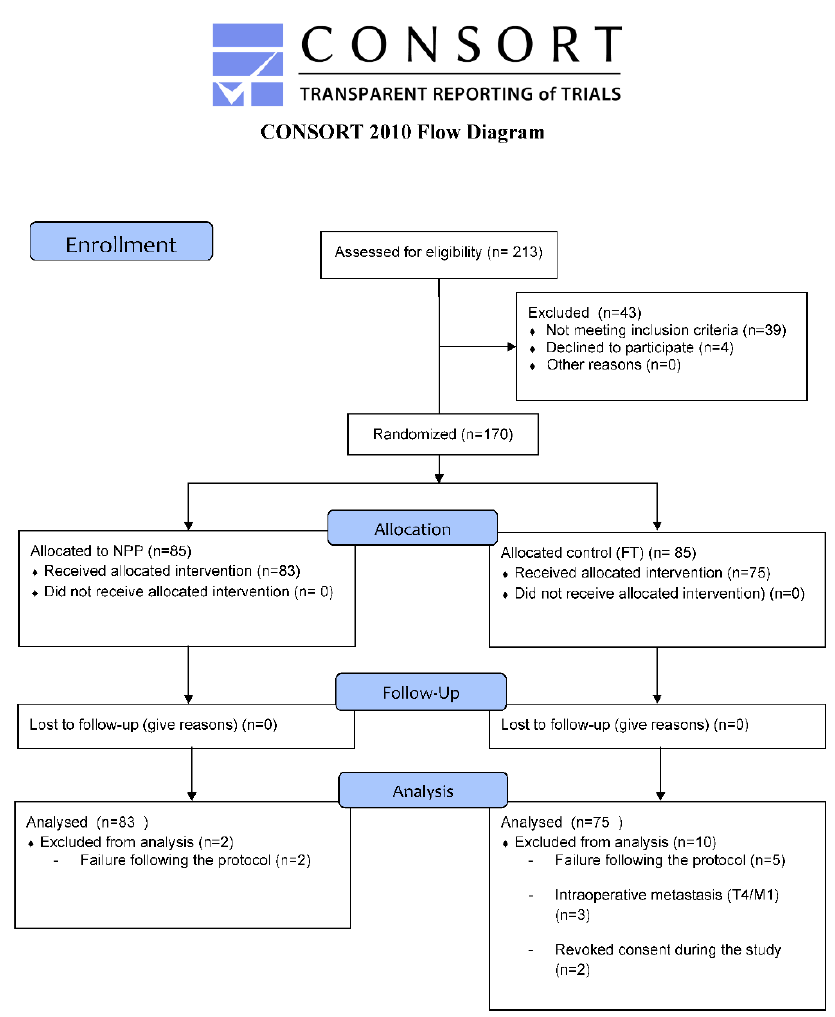
Figure 2. Flowchart of patient in the study. Table 1. Demographic, preoperative, surgical, and pathological data of study population.